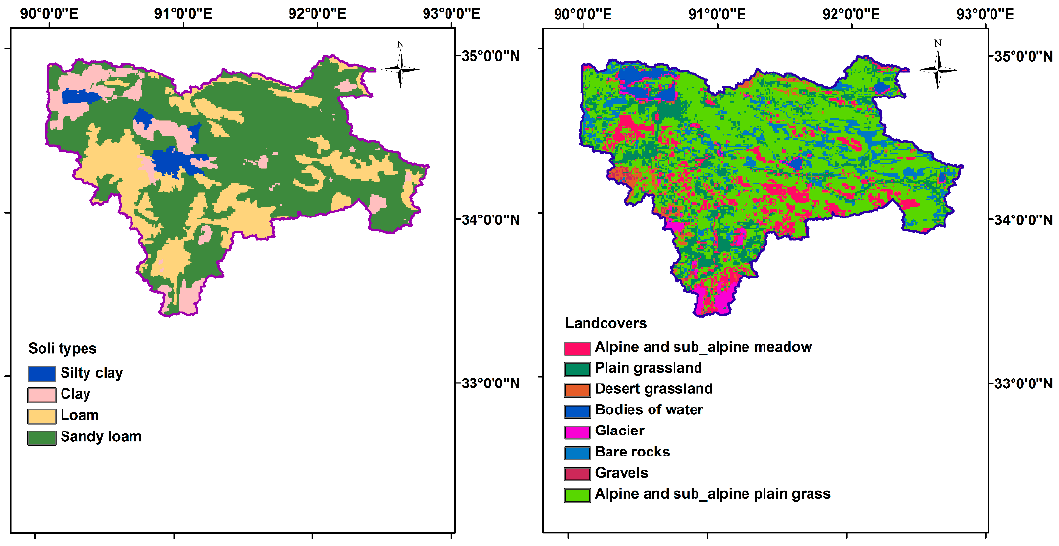
Figure 2. Soil types and land covers over the study area.